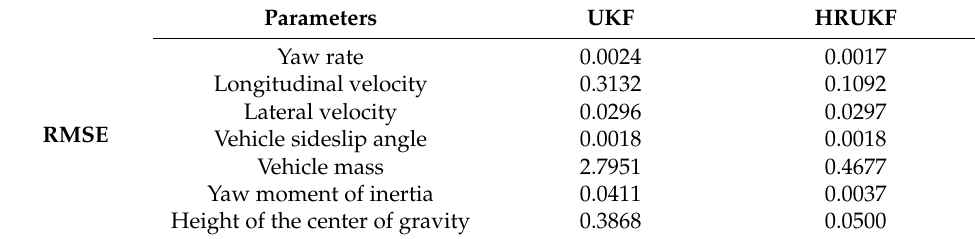
Table 2. Root mean square error (RMSE) index for double-lane change conditions.